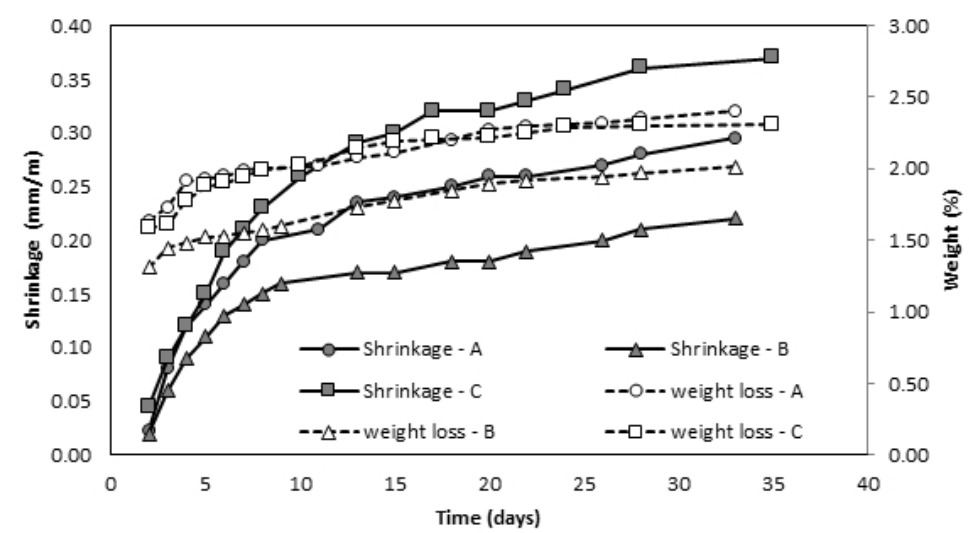
Figure 4. Results of shrinkage measurement.